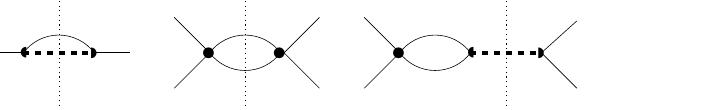
Figure 4. The Feynman graphs contributing to the CTP parameters. The time inverted version of the last graph enters, as